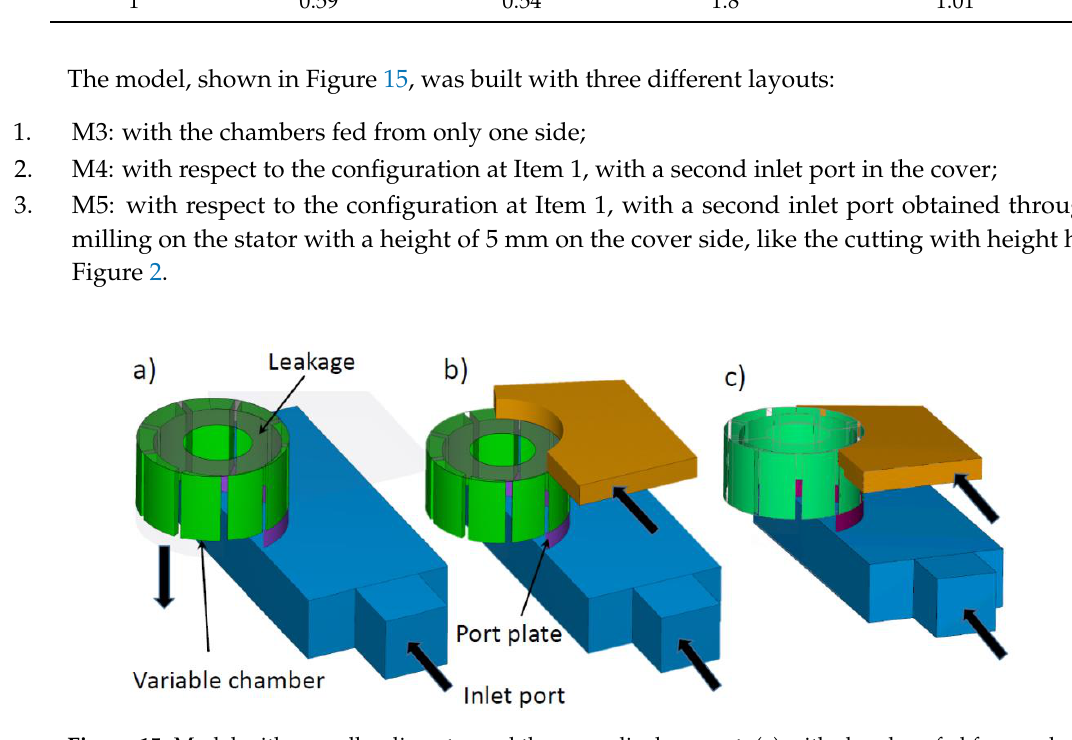
Table 5. Flow rate and volumetric efficiency at 5000 rpm and 7500 rpm, with three layouts of the suction ports, and a rotor with small diameter.